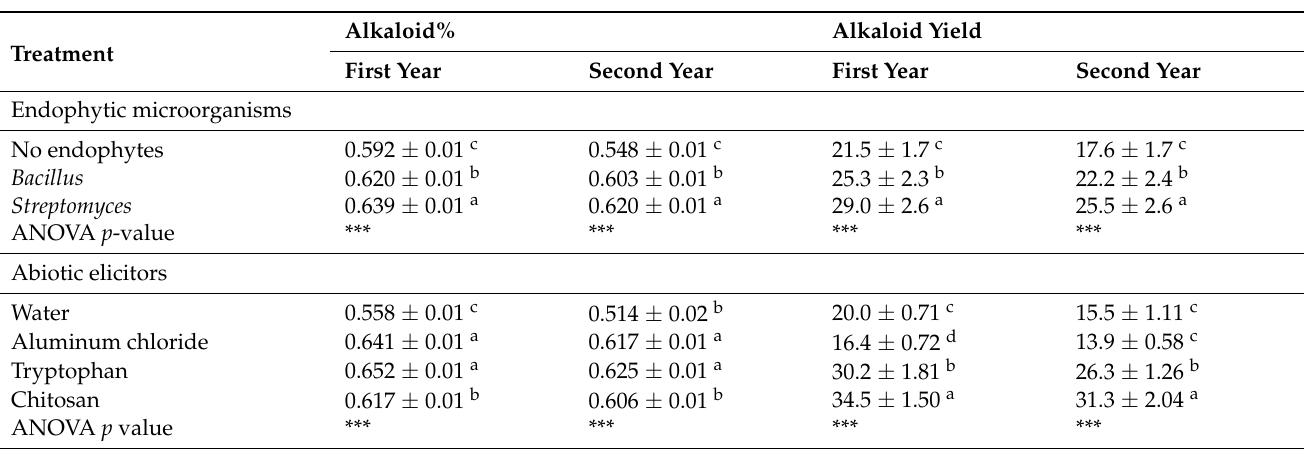
Table 6. Effect of endophytic microorganisms and abiotic elicitors on alkaloid percentage and alkaloid yield (mg plant − 1 DW) of periwinkle plant shoot in both seasons. Means of five replicates are presented with ±